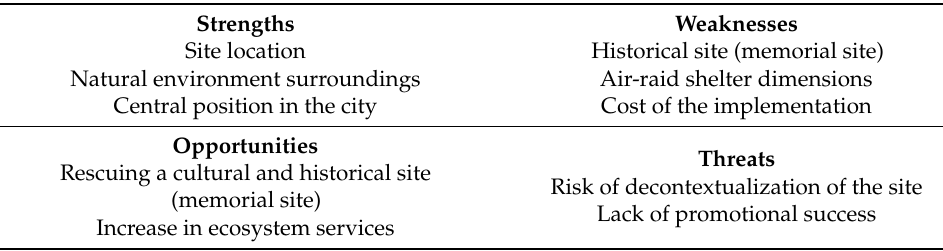
Table 1. SWOT analysis of the feasibility study.